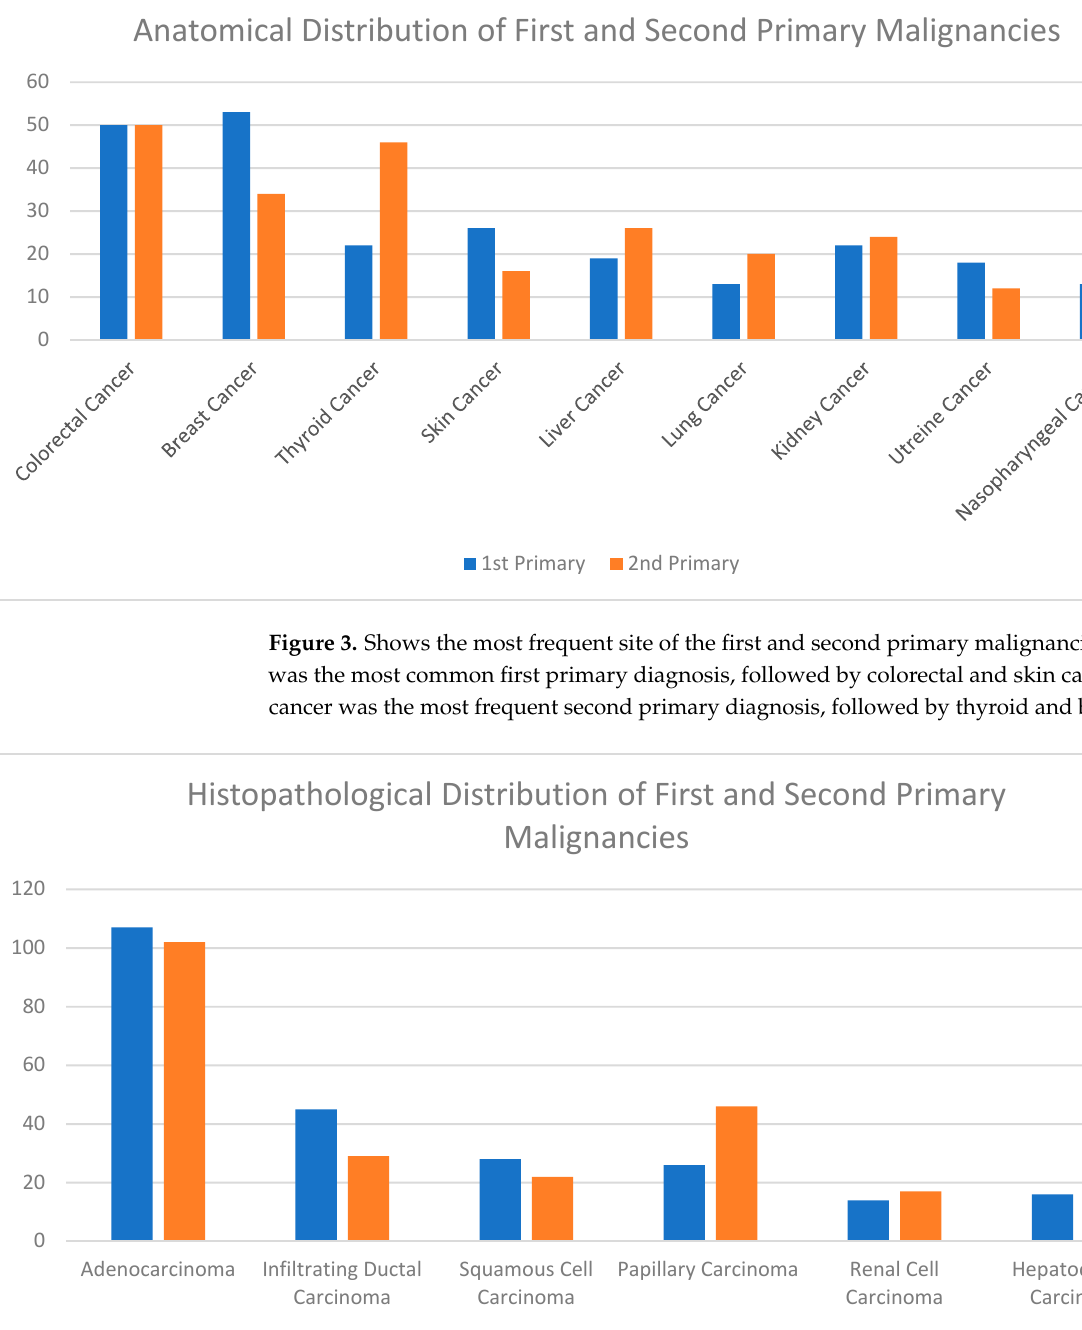
Figure 2. An alluvial plot showing stages of first and second primary malignancies. Detailed de- scription: A total of 10.9% of the patients had their first primary malignancy diagnosis when it al- ready metastasized to a distant organ, 21.8% had regional metastasis, and the rest had localized disease. A total of 16.8% of the patients had metastatic disease when diagnosed, 17.8% had regional metastasis, and the rest had localized disease .